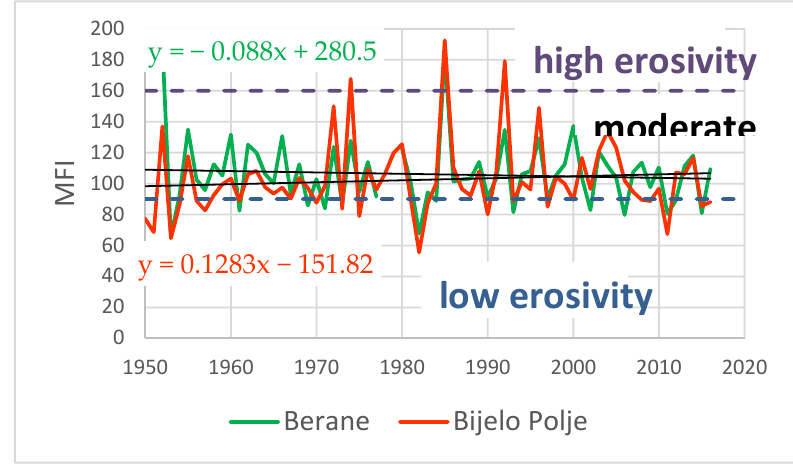
Figure 6. Long term variation of the Modified Fournier Index-MFI